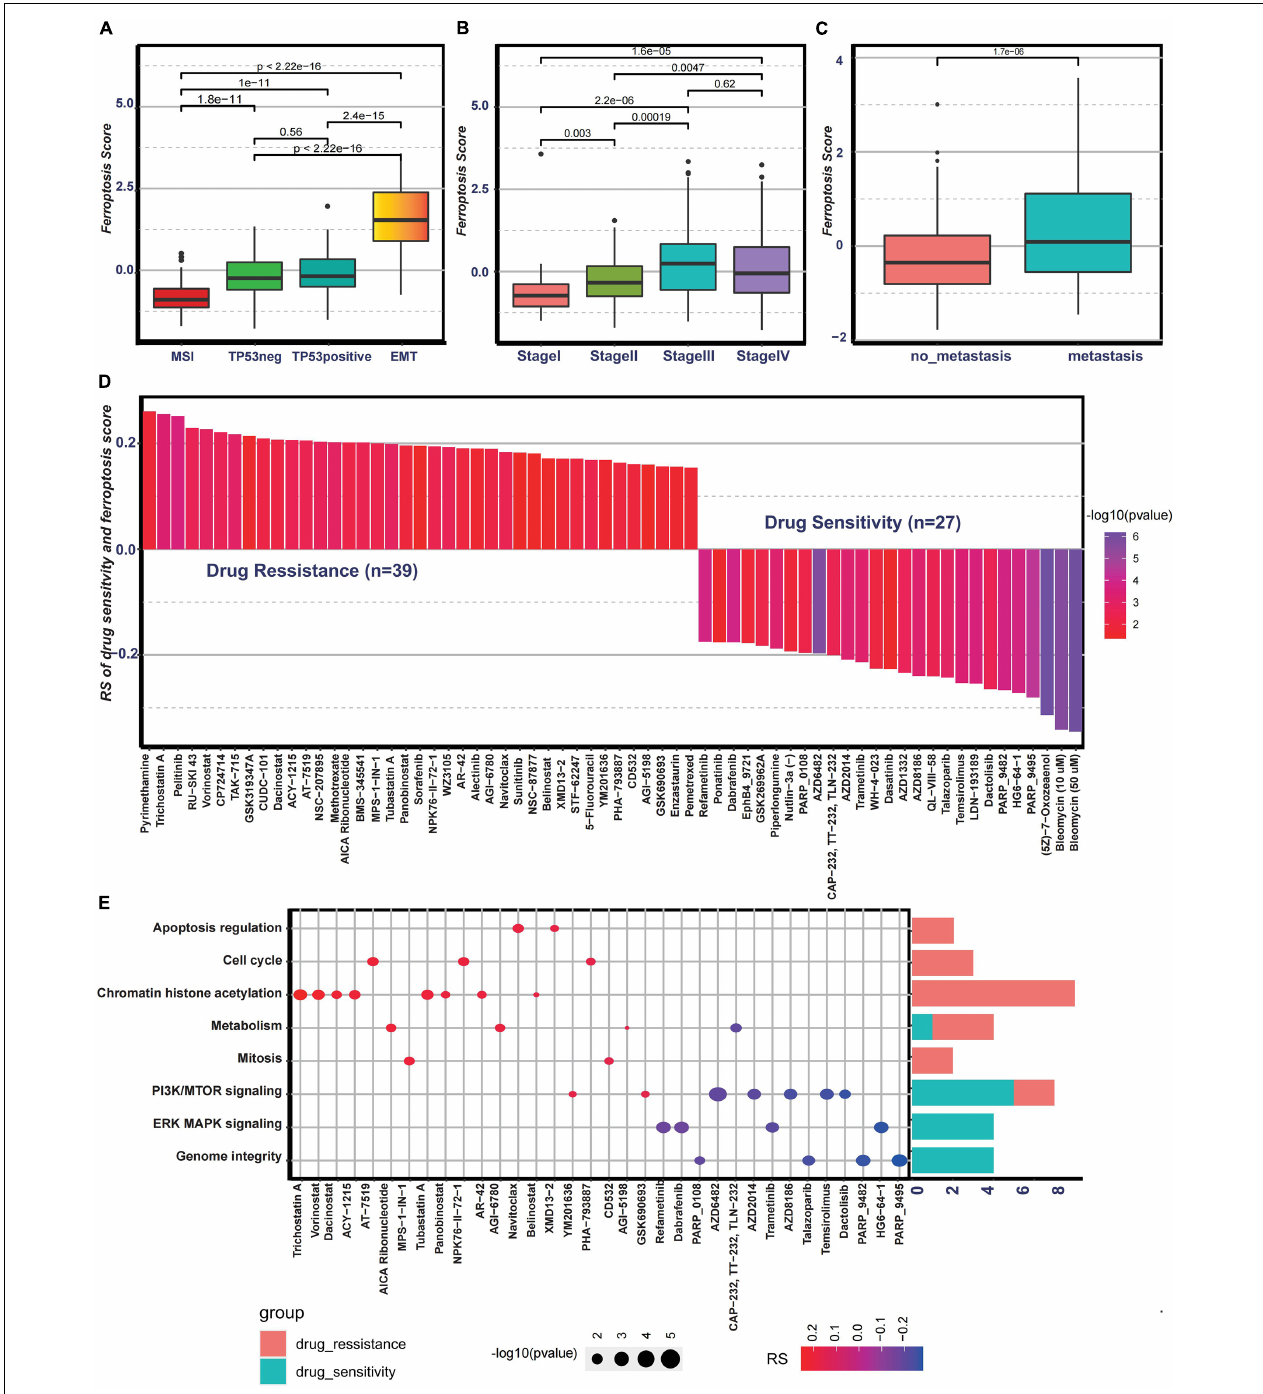
FIGURE 6 | Association between the ferroptosis score and clinical characteristics and the predictive value of the ferroptosis score for drug sensitivity. (A) Differences in the ferroptosis scores among the Asian Cancer Research Group (ACRG) molecular subtypes. (B) Differences in the ferroptosis scores among different stages in the ACRG cohort. (C) Differences in the ferroptosis scores between the metastatic and non-metastatic groups in the ACRG cohort. (D) Correlation between the ferroptosis score and drug sensitivity evaluated by Spearman’s analysis. The types of drugs are represented by each column . The significance of the correlation between the ferroptosis score and drug sensitivity is represented by the brightness of the column . The correlation degree is represented by the height of the column . (E) Signaling pathways targeted by drugs showing sensitivity ( red ) or resistance ( blue ) to the ferroptosis score. The size of each point represents the significance degree of correlation. The right bar plot shows the relative frequency of drugs showing sensitivity or resistance to the ferroptosis score in each distinct targeted signaling pathway.